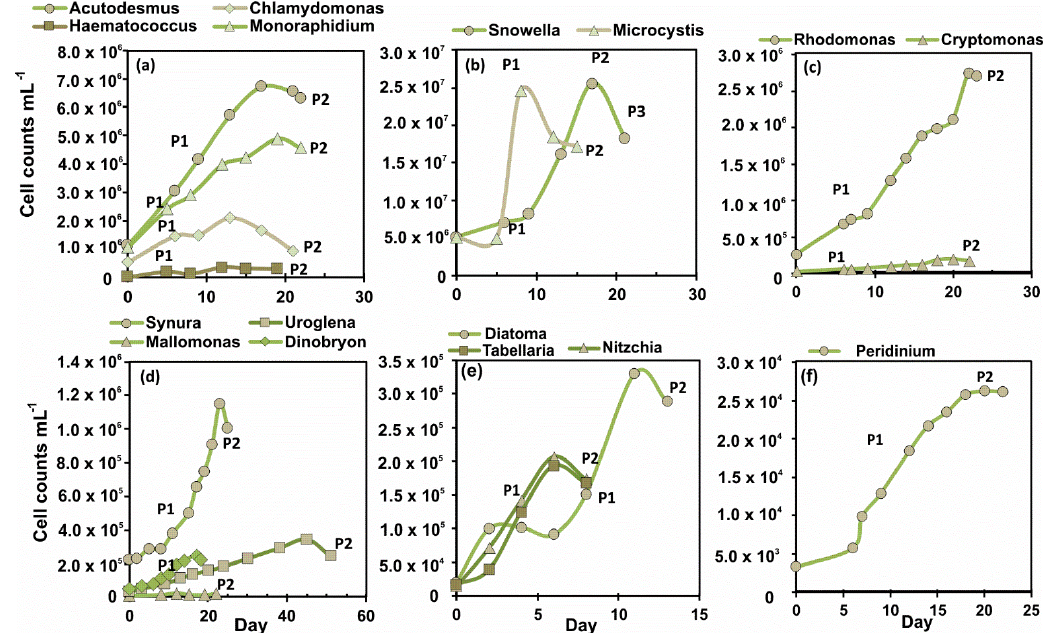
Figure 1. Growth curves for 16 cultures of phytoplankton strains classified by phytoplankton groups: ( a ) green algae, ( b ) cyanobacteria, ( c ) cryptophytes, ( d ) golden algae including chrysophytes and synyrophytes, ( e ) diatoms, and ( f ) dinoflagellate. P1 cites to sampling point during exponential growth phase and P2 cites to the sampling point in stationary